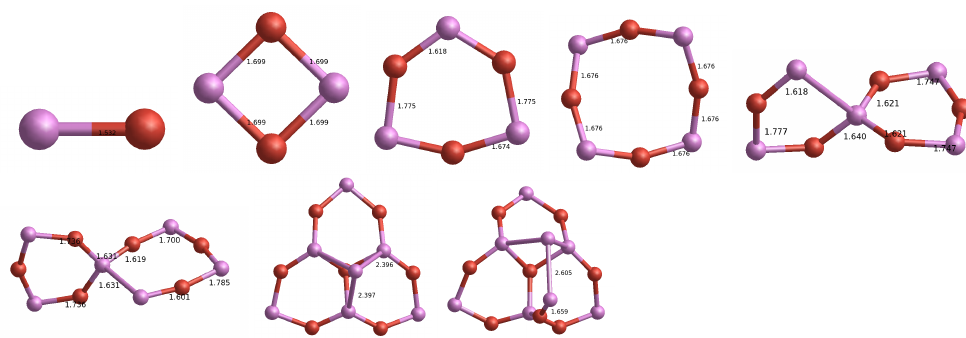
Figure 3. The adiabatically optimized stuctures of (SiO) n cations. Si atoms are in violet, O atoms in red, numbers correspond to bond distances in